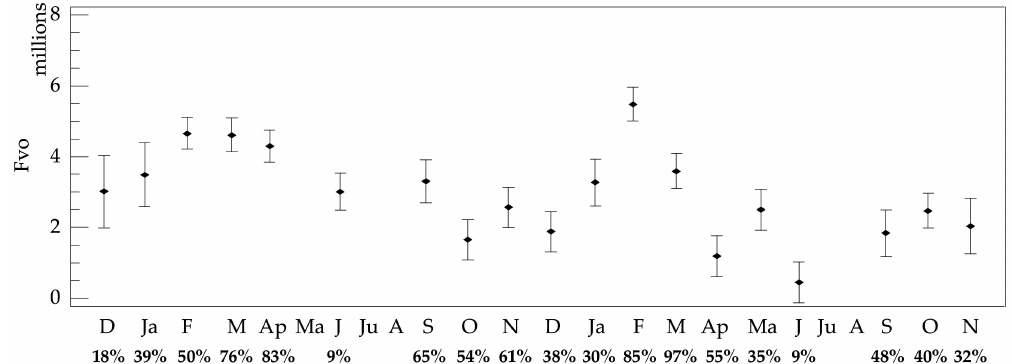
Figure 7. Temporal trends of the mean per female fecundity, Fvo ± Fisher LSD, of Paracentrotus lividus in the Pagasitikos Gulf (data were pooled across both stations). The percentage of females having oocytes (oogenetic stages III, IV, and V) and, therefore, used to estimate fecundity is marked below each sampling